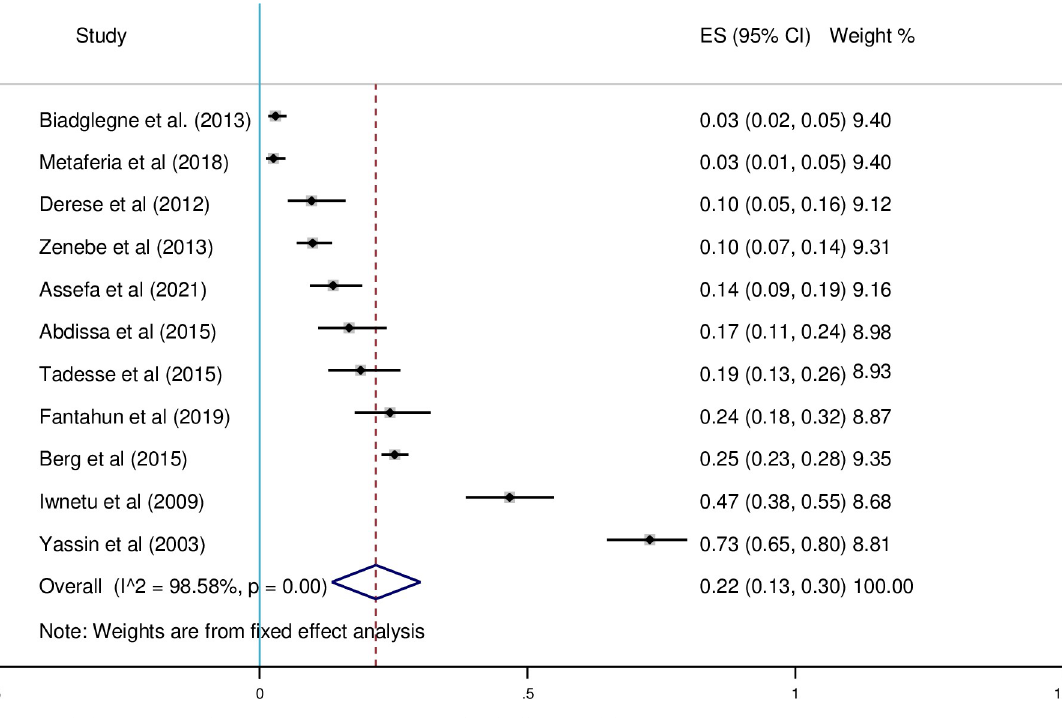
Fig 5. Pooled proportion of smear-positive EPTB using a fixed-effects model.